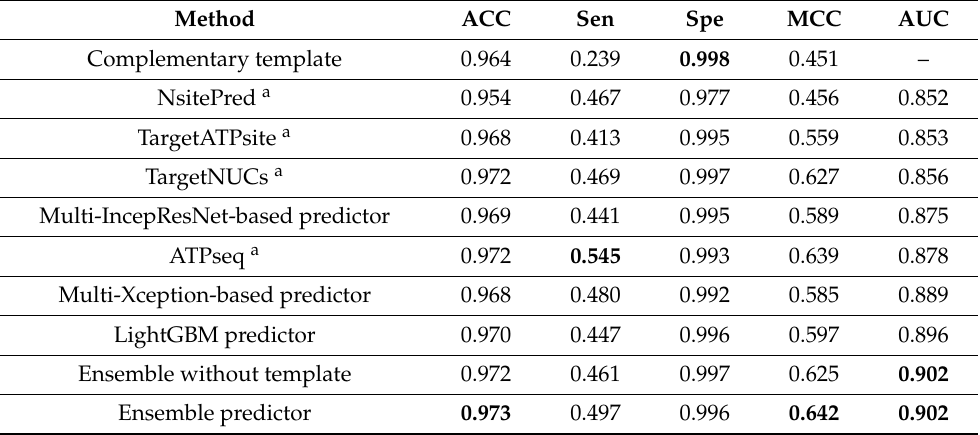
Table 2. Performance comparison between our proposed method and other sequence-based methods on the ATP-41 testing set (methods are ranked according to AUC and the highest value of each column in the table is shown in bold).